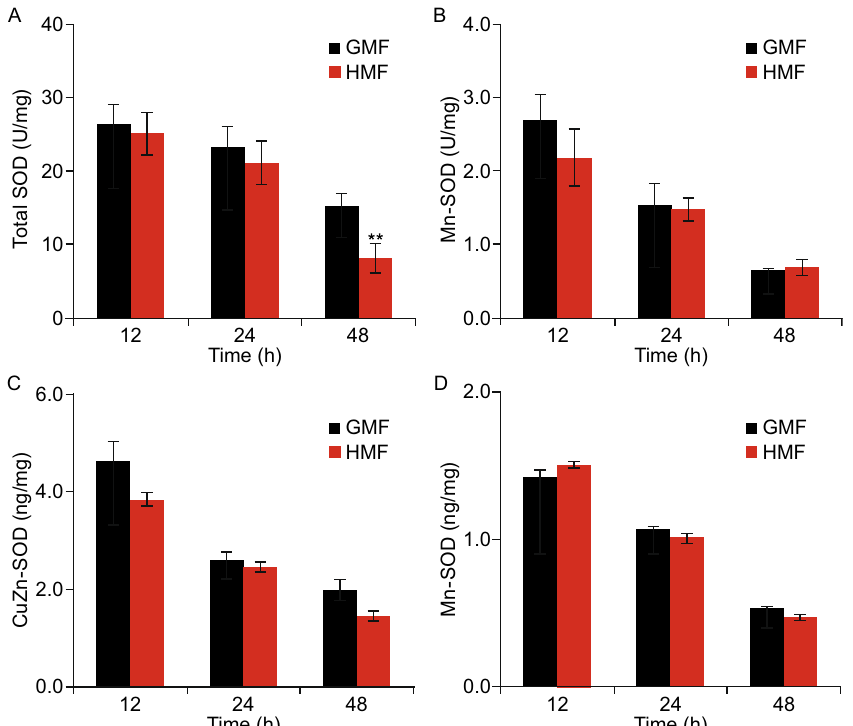
Figure 4. The HMF inhibits the activity of SOD. (A) The activity of total SOD was lower in the HMF group than that in the control at 48 h ( n = 6). (B) The activities of Mn-SOD in the HMF and GMF groups were at the same level along the incubation period ( n = 6). The expressions of CuZn-SOD (C) and Mn-SOD (D) detected by ELISA were at the same level between the HMF and GMF groups ( n = 3). n is the total number of samples from three independent experiments. Data were shown as mean ± s.e.m. The P values were calculated using one-way ANOVA. ** P < 0.01.